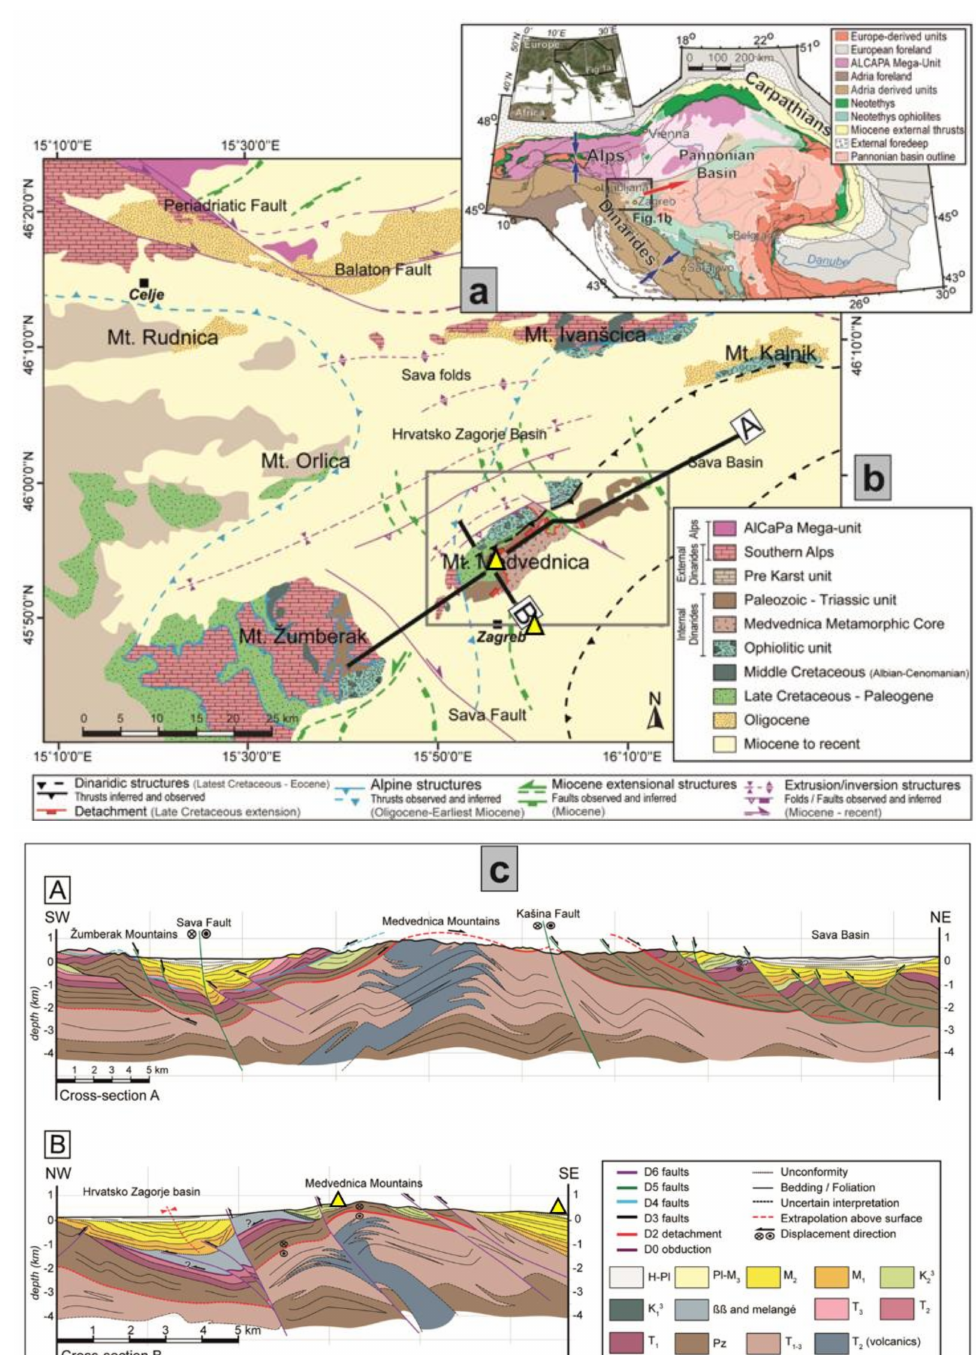
Figure 1. ( a ) Simplified tectonic map of the Alpine, Carpathian and Dinaric orogenic belts and the Pannonian basin. ( b ) Tectonostratigraphic map of the Medvednica Mountains and surrounding areas near the Alpine-Dinaridic junction. ( c ) Longitudinal ( A ) and transversal ( B ) cross-sections of the Medvednica Mountains (location on the Figure 1b). (from [19]). Location of seismological stations Puntijarka (PTJ-on the top of Medvednica Mountains) and Zagreb (ZAG-on the unconsolidated alluvial cover) are marked with yellow